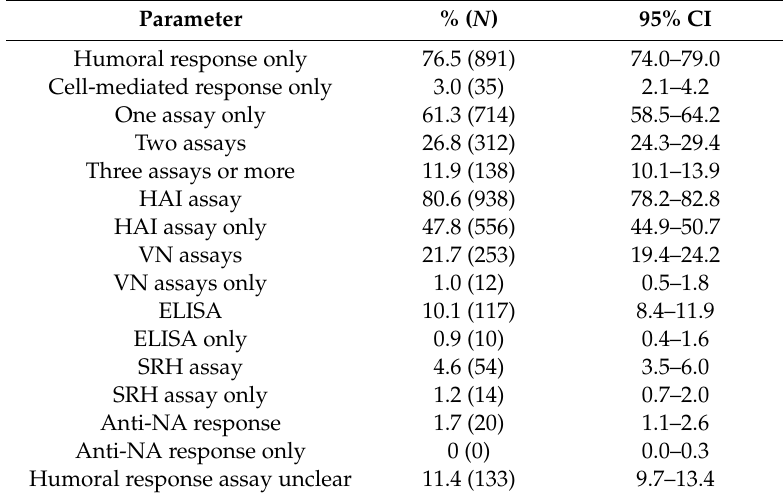
Table 1. Frequency of the immunological assays used in the clinical trials included ( N =